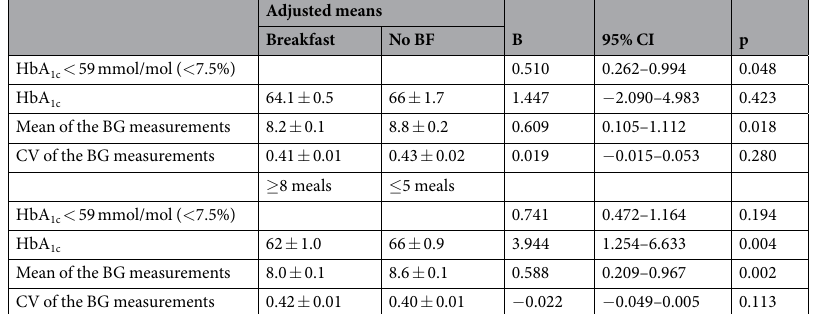
Table 5. Associations between breakfast consumption, meal frequency and glycaemic control. Models are adjusted for sex, diabetes duration, smoking, energy intake, physical activity, and mode of insulin administration. Logistic regression analysis for the dichotomised variable (HbA 1c < 59 mmol/mol), and generalised linear regression analysis for the continuous variables. BF, breakfast; BG, blood glucose; CV, coefficient of variation. In the logistic regression analyses, breakfast = 0, no breakfast = 1; ≥ 8 meals = 0, ≤ 5 meals =